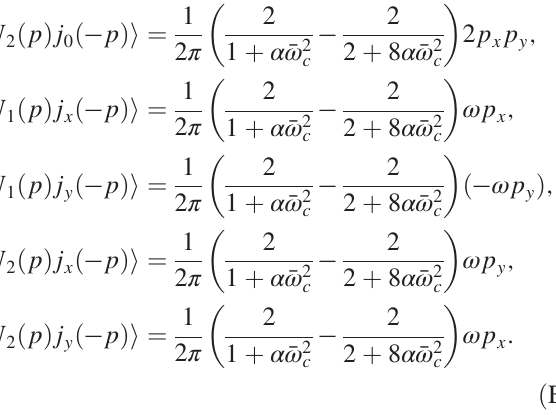
FIG. 2. Diagrams contributing to the Wen-Zee term. Here, the wiggly line represents the gauge field a μ and the dotted line represents the nematic field M . The thick line represents the i composite fermion